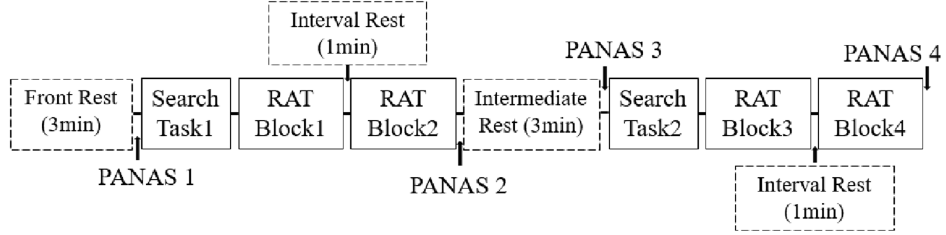
Figure 2. The sequence of single day’s